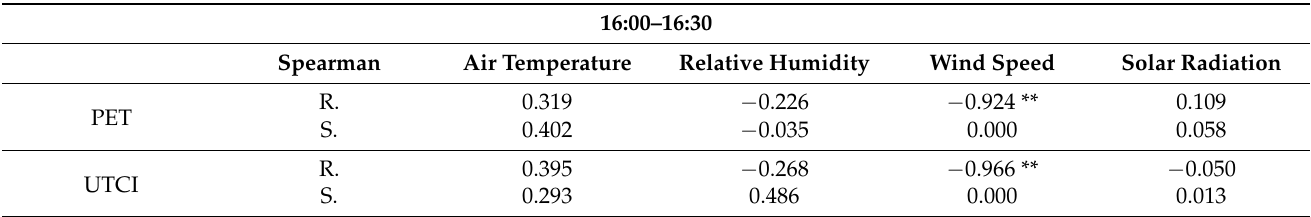
Table 8. The Spearman correlation coefficients of the measured microclimatic parameters and PET and UTCI of 16:00 to 16:30.